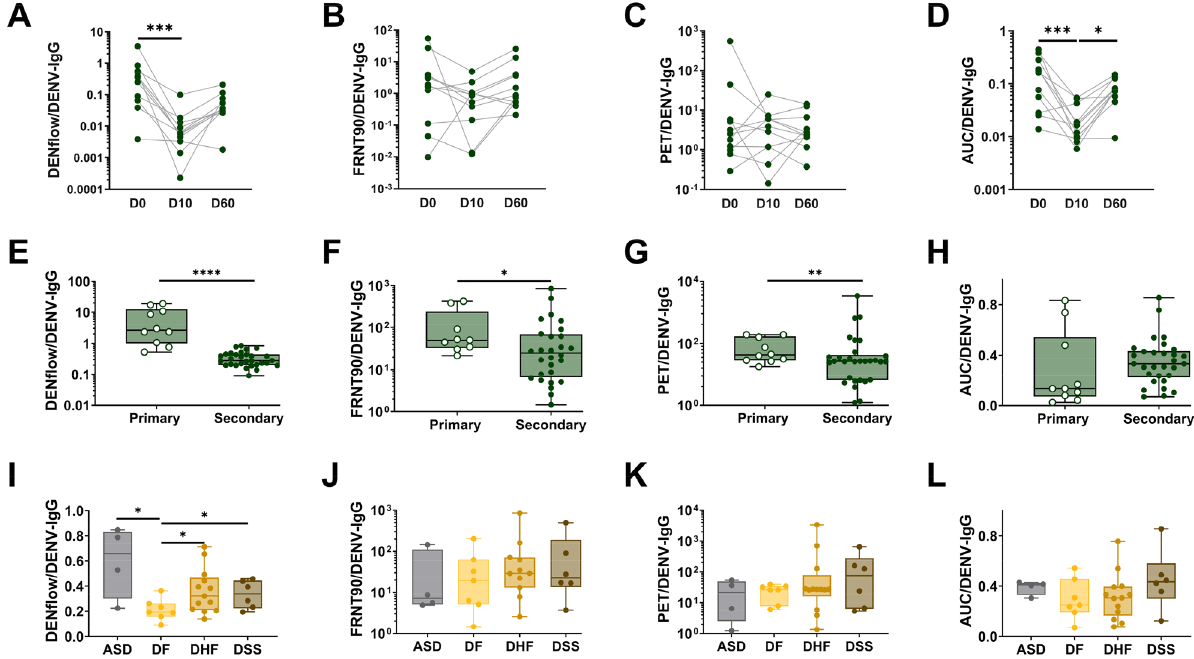
Figure 4. Proportions of neutralizing antibodies and enhancing antibodies within the total DENV-IgG titer. Proportions of DENflow, FRNT90, PET or AUC within the total anti-DENV IgG antibodies in plasma obtained from paired-secondary samples at different time points (D0, D10 and D10) from cohort 1 ( A-D ), in plasma obtained from primary infected patients compared to secondary infected patients from cohort 2 (6–8 days after max, min, median values and the interquartile range beyond the 25th and 75th percentiles. Mann–Whitney test was used to compare two patient groups (* P < 0.05; ** P < 0.01, *** P < 0.00; **** P <